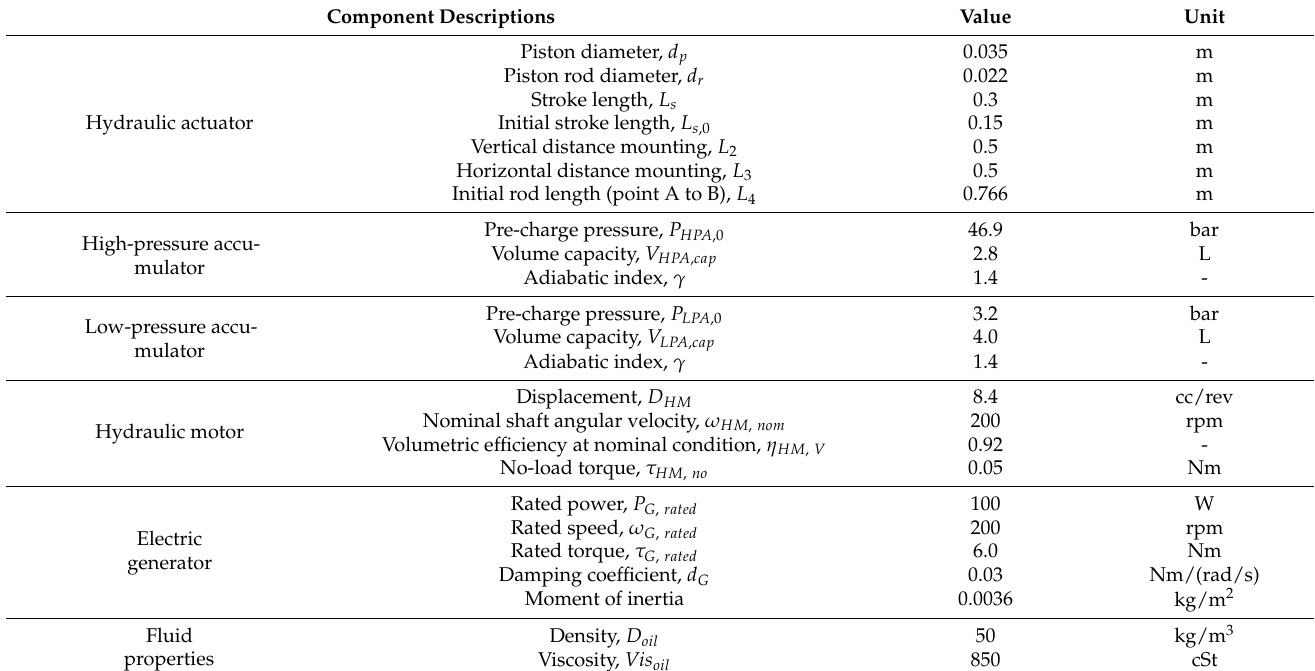
Figure 3. A complete model of WEC with HPTO unit in MATLAB/Simulink. ( A ) WEC device model, and ( B ) HPTO unit model. Table 2. Detailed specifications of the developed HPTO